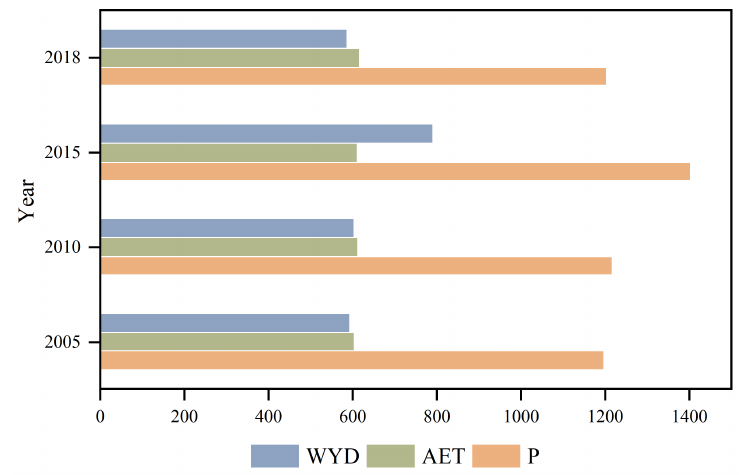
Figure 3. WYD, AET, and P represent water yield depth (mm), actual evapotranspiration (mm), and precipitation (mm).